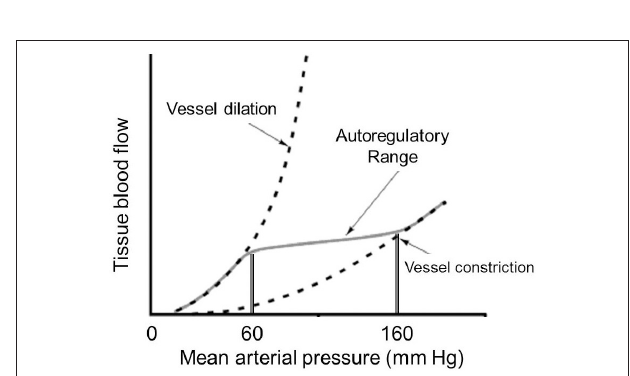
FIGURE 2 | Curve reflecting tissue autoregulation for maintaining consistent blood flow across varying systemic perfusion